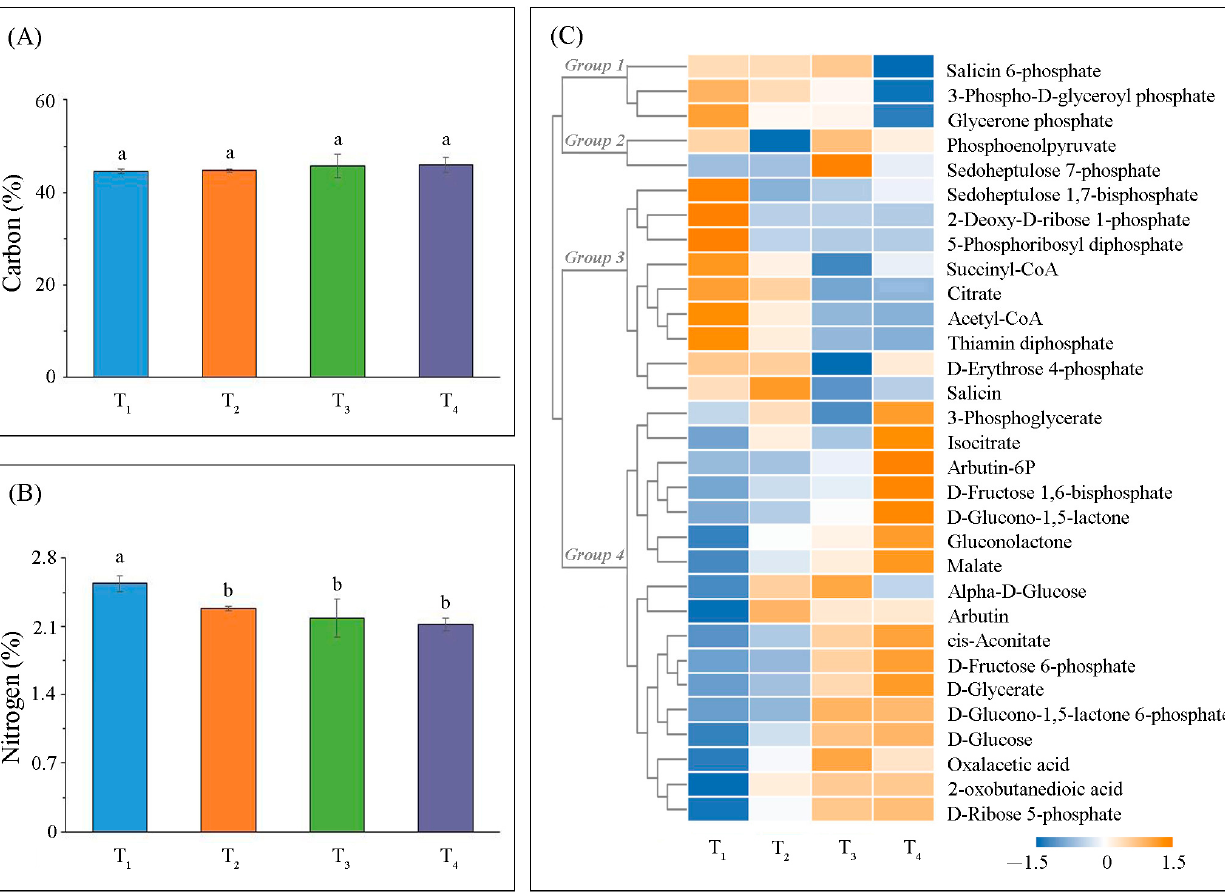
Figure 3. Variation in metabolic levels in the different leaf-developmental stages. Total carbon ( A ) and total nitrogen ( B ) contents (error bars indicate standard deviations, and small letters represent a significant difference ( p < 0.05)). A hierarchical clustering heatmap highlighting quantified ginkgo metabolites presented in logarithmic scale (log 2 (x)) where x is metabolites abundance ( C ) (change in color of the rectangle from orange to blue represents a gradual decrease in the metabolites abundance).